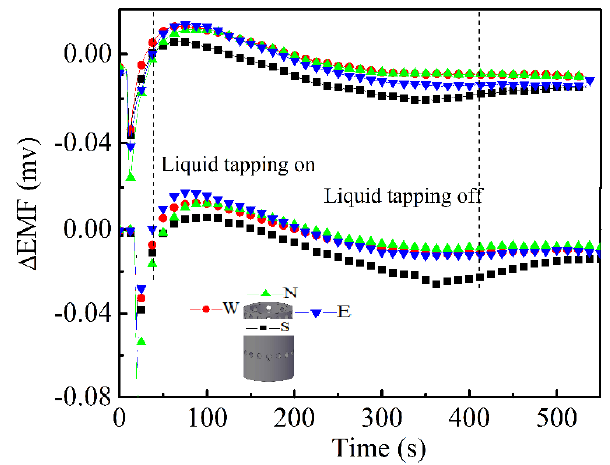
Figure 8. EMF signals around the circumference at outer wall ( top ) and inner wall ( bottom ) along south direction.